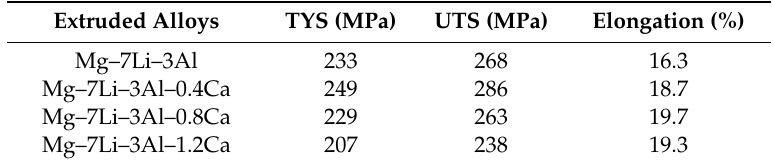
Figure 5. Stress–strain curves of the extruded Mg–7Li–3Al–xCa alloys at room temperature. Table 3. Mechanical properties of the extruded Mg–7Li–3Al–xCa test alloys at room temperature.